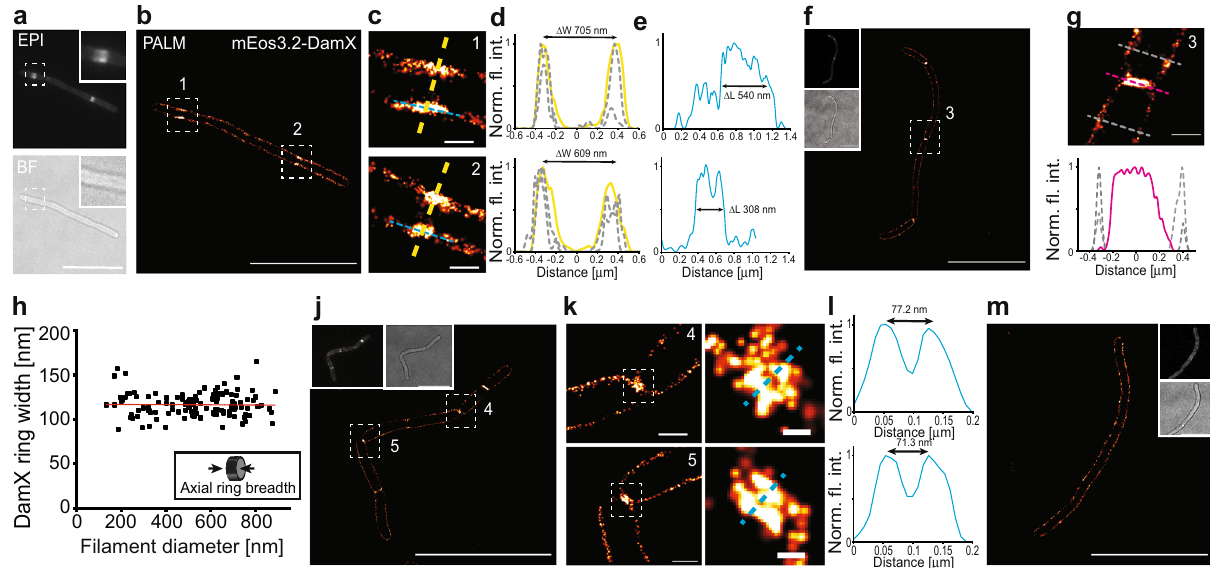
Fig. 5 DamX localizes at the division site prior to membrane constriction. Filaments expressing mEos3.2-DamX harvested from the back-end of fl ow chambers after infections were grown in LB for 1 h before imaged using single-molecule microscopy. a mEos3.2-DamX localized at multiple division sites simultaneously and accumulated prior to visible invagination of the membranes. Insets: Close-up images of mEos3.2-DamX and the corresponding bright- fi eld image. b PhotoActivatable Localization Microscopy (PALM) image of the same fi lament as in a . c Close-up images (1) and (2) of the mEos3.2-DamX ring assemblies at division sites prior to condensing into a ring structure (from b ). d Fluorescence intensity plots of the mEos3.2-DamX assemblies and membrane widths. Plots showing ring and membrane widths; yellow lines represent ring assemblies; grey dotted lines represent membrane widths 1 μ m up and downstream of the mEos3.2-DamX accumulation. Δ W indicates the peak-to-peak distances. e Length of the molecule assemblies along the length axis of images in c . Δ L indicates the length of the intensity pro fi le at 50% of the intensity. f PALM image of a typical fi lament during reversal. g Close-up image of a constricting mEos3.2-DamX ring (3), fl uorescence pro fi le underneath: yellow line represents the ring, grey represents membrane width. h Axial breadth of mEso3.2-DamX rings along the length of the fi laments at various cell diameters. Average width 116.5 ± 13.4 ( n = 122), values represent mean ± SD. Red line represents linear fi t to the data: y = − 0.009* x + 116. j mEos3.2-DamX remains at the old division septum after membrane separation. k Close ups of old division sites from j (4) and (5). l Peak-to-peak distance of fl uorescence intensities of the membrane assemblies of mEos3.2-DamX. m A typical fi lament before division sites have been de fi ned. Scale bars ( a , b , f , j , m ) = 10 μ m, ( c , g , k left ) = 500 nm, ( k right ) = 100 nm. Source data are provided as a Source data fi